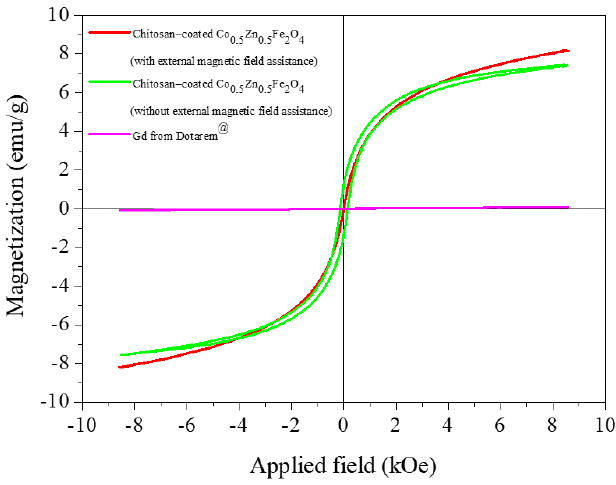
Figure 5. Room temperature magnetization curve of chitosan-coated Co 0.5 Zn 0.5 Fe 2 O 4 nanoparticles (with and without 400 mT of external magnetic field assistance) and Gd from Dotarem ® (Guerbet, Roissy CdG Cedex, France).